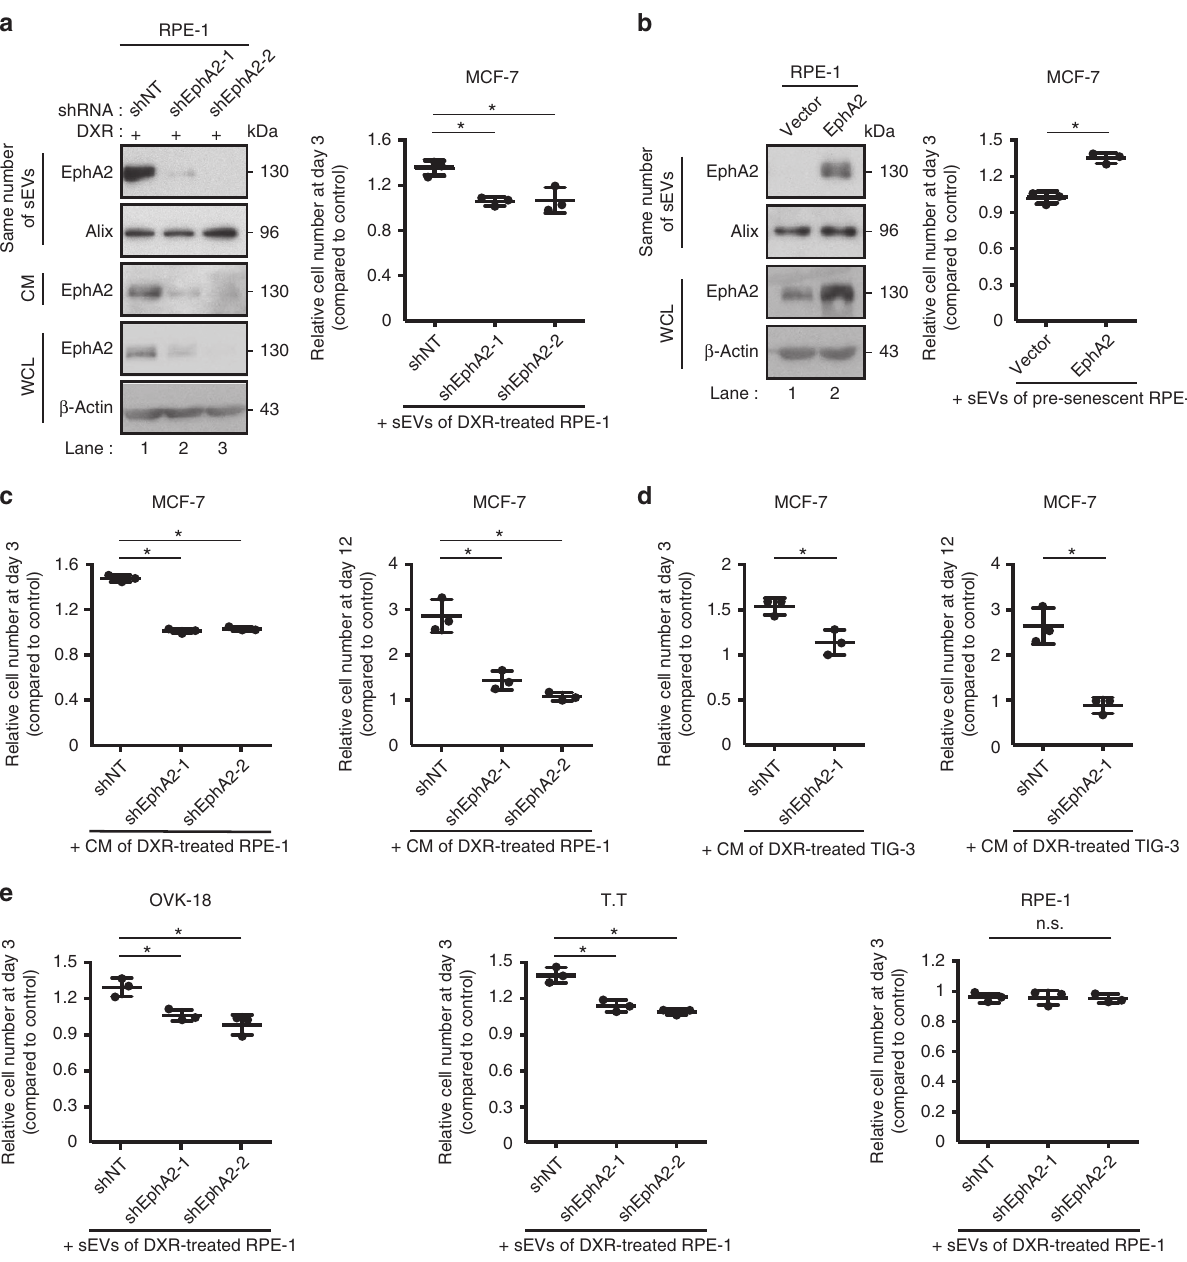
starting the experiments) grown for 3 days in the presence of sEVs compared with the number of cells grown for 3 days in normal medium. sEVs were purified from DXR-induced senescent RPE-1 cells expressing shNTor shEphA2 and added to the medium at a concentration of 2 (cid:2) 10 9 particles per ml. The basal proliferation rates, that is, the fold increase in cell numbers of untreated OVK-18, T.T and RPE-1 cells at culture day 3, were 2.24, 3.48 and 10.72, respectively. Replicates are biological replicates ( n ¼ 3). Error bars indicate s.d. * P o 0.05 (one-way ANOVA with the post-hoc Dunnett’s two-tailed test for a , c , e and two-tailed t -test for b , d